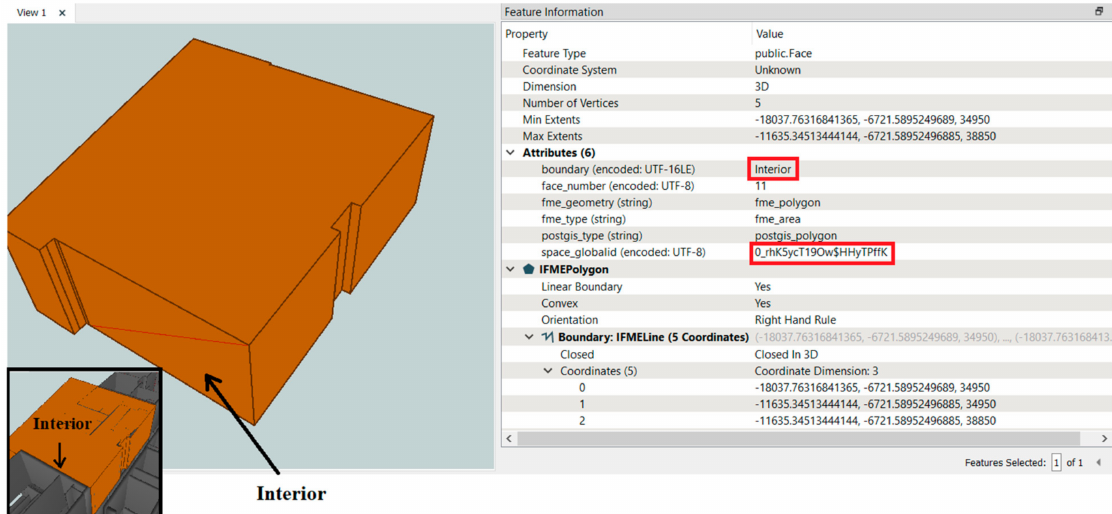
Figure 25. An Interior boundary for the lot with the Globalid: 0_rhK5ycT19Ow$HhyTPffK associated with the